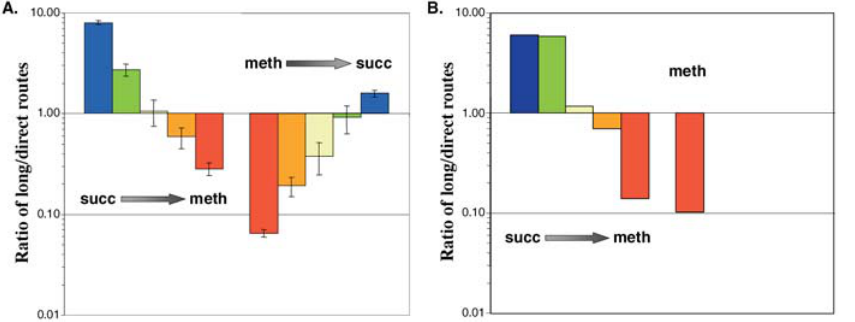
Figure 3. Change in Ratio of Flux through Long Versus Direct Methylene-H 4 F Formation Routes during Growth Transitions (A) Experimental data as determined by GC–MS analysis of serine isotopomers. The bars for each transition represent a time series from cells harvested 1 h prior to the transition, and four time points following the transition (succinate to methanol: 1, 5, 7.5, and 10 h; methanol to succinate: 1, 3, 5, and 7 h). (B) Predictions based on kinetic model simulations. The bars indicate the succinate to methanol transition (same time points as for the